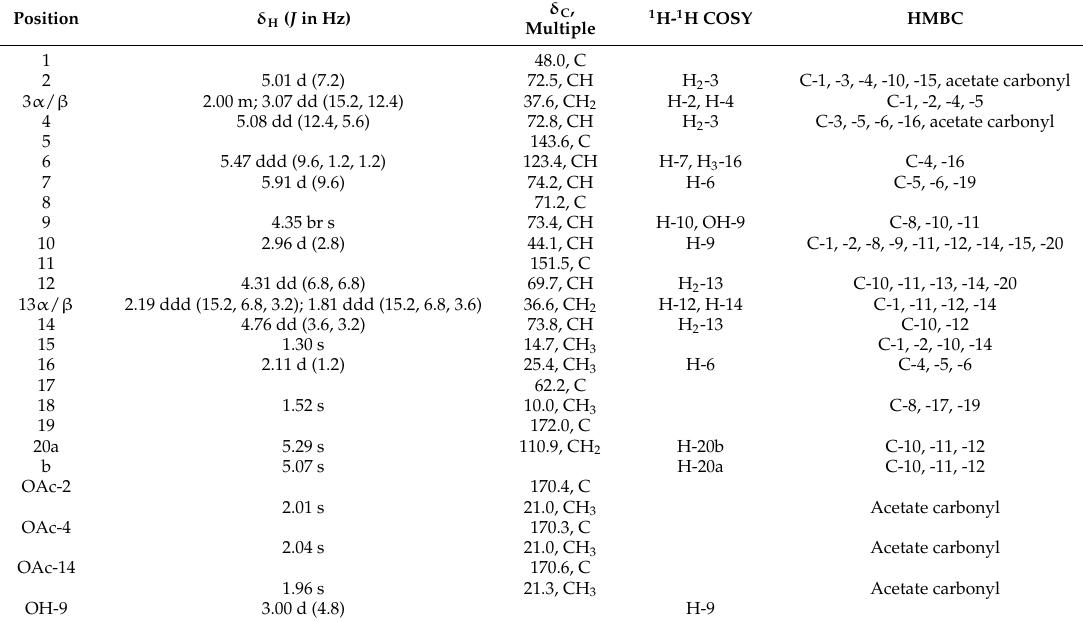
Table 2. 1 H (400 MHz, CDCl 3 ) and 13 C (100 MHz, CDCl 3 ) NMR data and 1 H- 1 H COSY and HMBC correlations for briarane 2